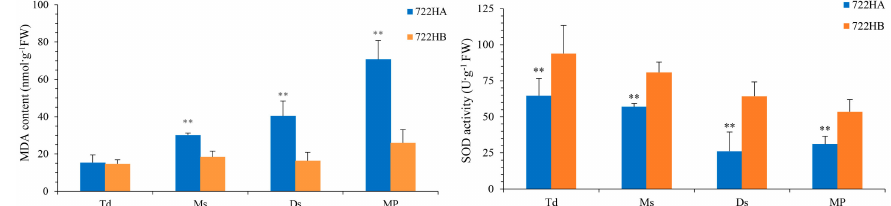
Figure 6. Malondialdehyde (MDA) contents and Superoxide dismutase (SOD) activity in the anthers of 722HA and 722HB at various developmental stages. Td: Tetrad stage; Ms: Mononuclear stage; Ds: Dinuclear stage; MP: Mature pollen grain stage. ( A ) MDA contents, ( B ) SOD activities. Significant di ff erences were assessed by Student’s t -test (** p <